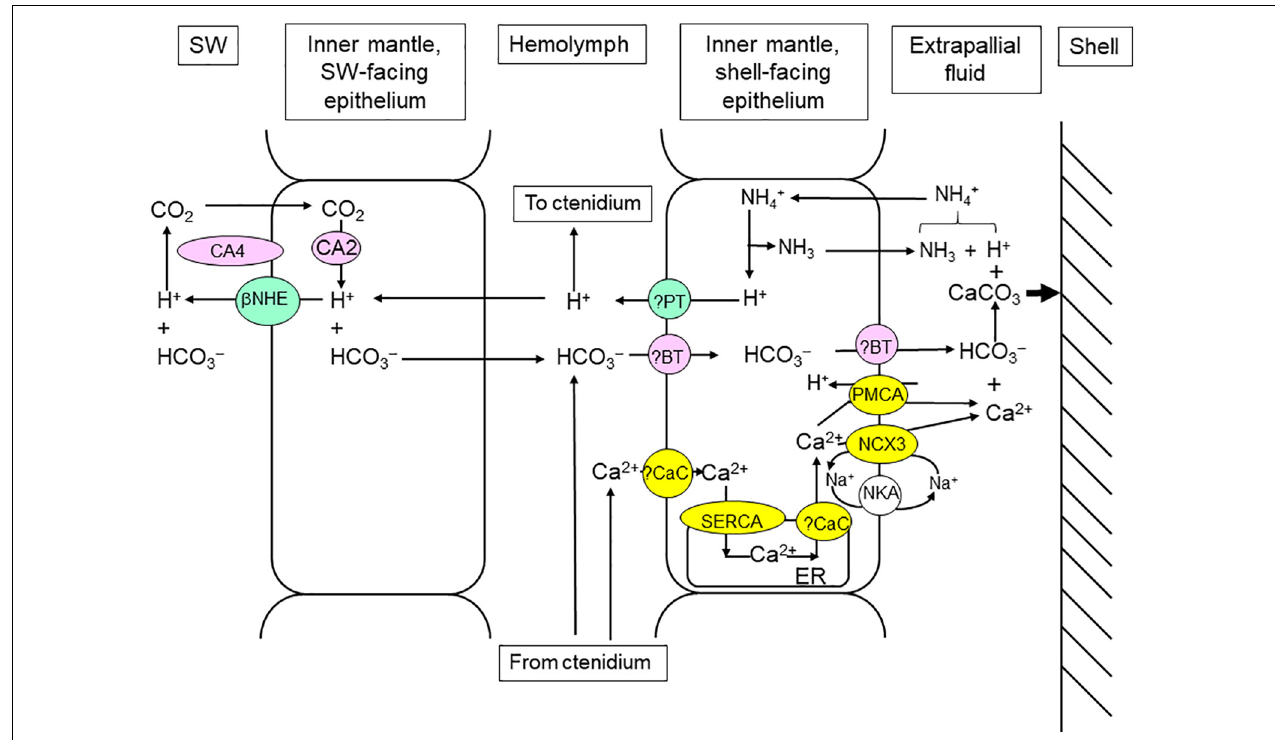
FIGURE 5 | Mechanisms of light-enhanced shell formation in the inner mantle of Tridacna squamosa . CaCO 3 is deposited from the extrapallial fluid onto the inside surface of the shell valve with the production of H + during shell formation. The supply of Ca 2 + and HCO 3 - (or C i ) to and the removal of H + from the extrapallial fluid increase during illumination. NH 3 may help to remove the excess H + produced during shell formation by combining with it to form NH 4 + (Ip et al., 2006). The H + produced can also be transported from the extrapallial fluid into the inner mantle epithelial cells through Plasma Membrane Ca 2 + -ATPase (PMCA; Ip et al., 2017a). Subsequently, the excess H + can be translocated to the hemolymph, followed by shuttling to the ctenidium for excretion (see Figure 2 ). The seawater-facing epithelium of the inner mantle also possesses Carbonic Anhydrase 4 (CA4; Chew et al., 2019) and Carbonic Anydrase 2 (CA2; Chew et al., 2019), and they operate collaboratively to assimilate C i from the ambient seawater. An apical beta Na + /H + Exchanger ( β NHE), which is expressed in the seawater-facing epithelium of the inner mantle, can excrete some of the excess H + generated (Cao-Pham et al., 2019a). The apical Na + /Ca 2 + exchanger 3 (NCX3) in the shell-facing inner mantle epithelium can deliver Ca 2 + to the extrapallial fluid at a high rate (Boo et al., 2019), while the apical PMCA can function to fine-tune cytosolic [Ca 2 + ] (Ip et al., 2018). The operation of NCX3 requires the support of Na + /K + -ATPase (NKA; Boo et al., 2017), and the movement of Ca 2 + inside the epithelial cells needs the participation of Sarcoplasmic Reticulum Ca 2 + -ATPase (SERCA; Chan et al., 2020). ER, endoplasmic reticulum. ?BT, unidentified Bicarbonate Transporters. ?CaC, unidentified calcium channel. ?PT, unidentified proton transporter. SW,